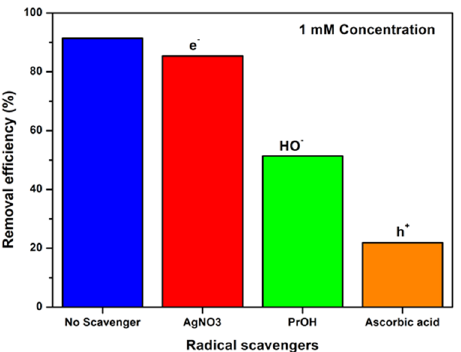
Figure 11. Photodegradation of KP in deionized water using CTG—500 membrane in the presence of various scavengers.